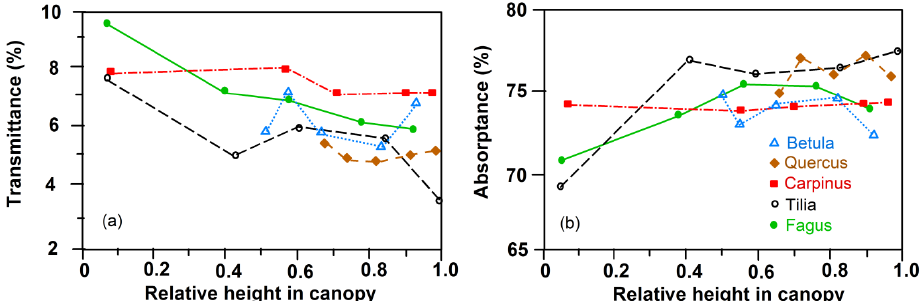
Figure 2. PAR-absorptance spectra of upper sun-canopy leaves of the five species with consideration of leaf specular properties. Depicted are mean curves of spectroradiometer measurements on each 10 leaves per species. For standard deviations of means see Figure S2 in the Supplement.